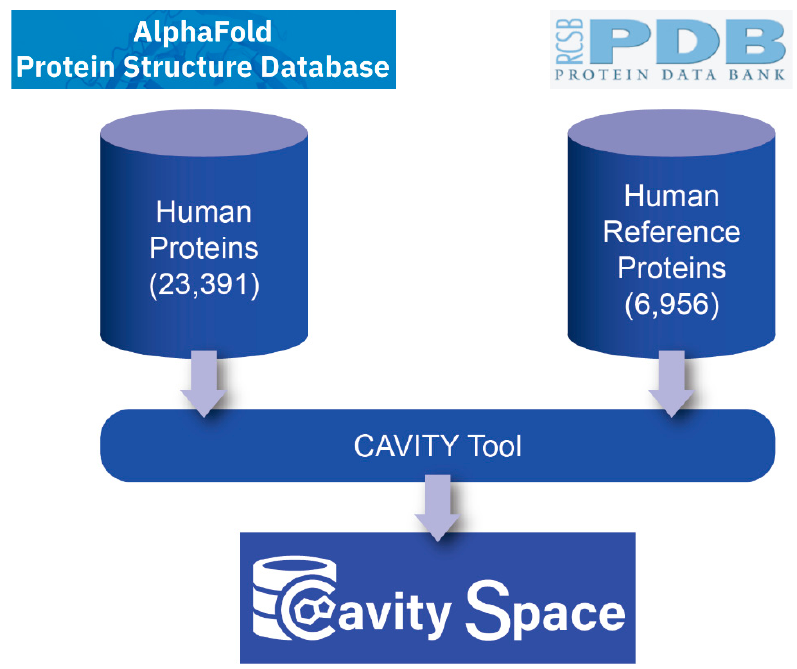
Figure 1. The flowchart for building CavitySpace.